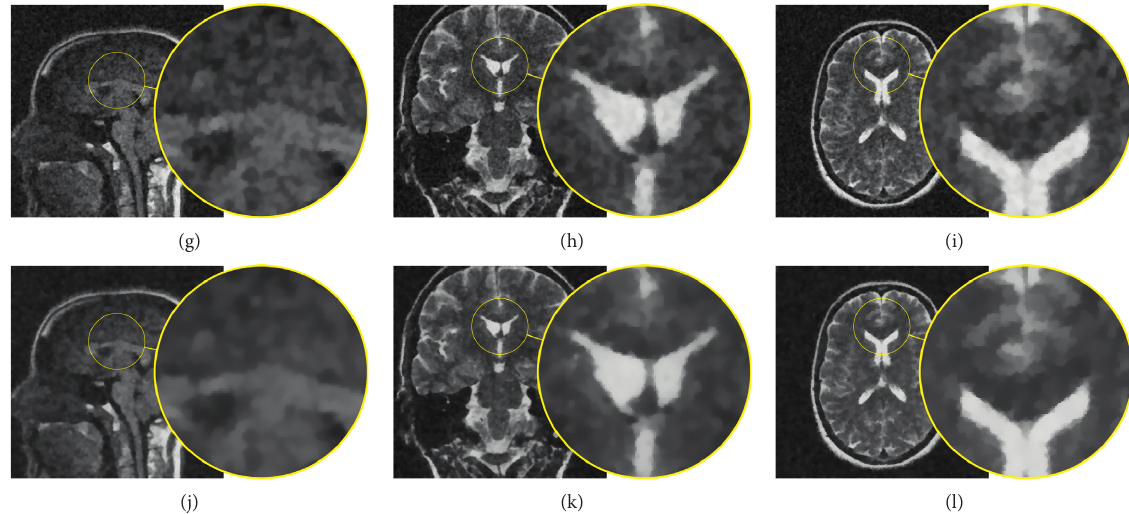
Figure 2: Visual comparison on different real images corrupted by Gaussian noise with σ 2 � 0 . 1 and restored images using both functions. (a) Original-Patient30. (b) Original-Patient50. (c) Original-Patient55. (d) Noisy-Patient30. (e) Noisy-Patient50. (f) Noisy-Patient50. (g) WZ-Patient30. (h) WZ-Patient50. (i) WZ-Patient55. (j) Proposed-Patient30. (k) Proposed-Patient50. (l)